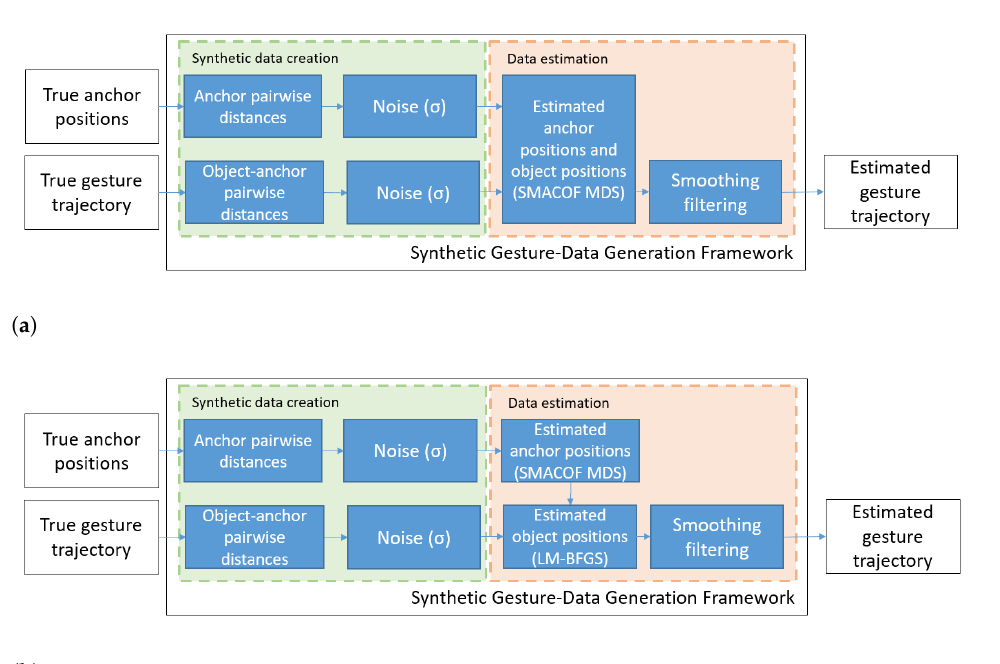
Figure 2. Proposed simulation framework, with ( a ) One-step approach and ( b ) Two-step approach, for the generation of synthetic gesture